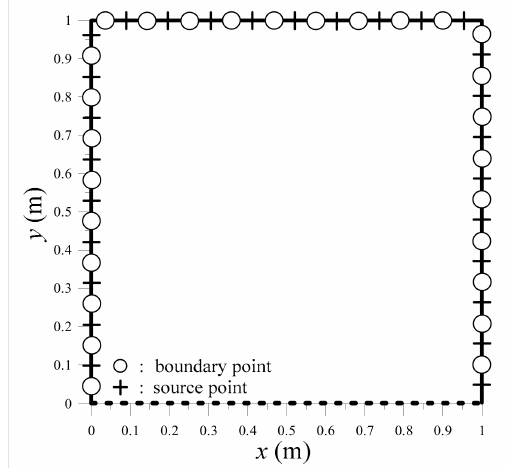
Figure 16. Boundary collocation points.